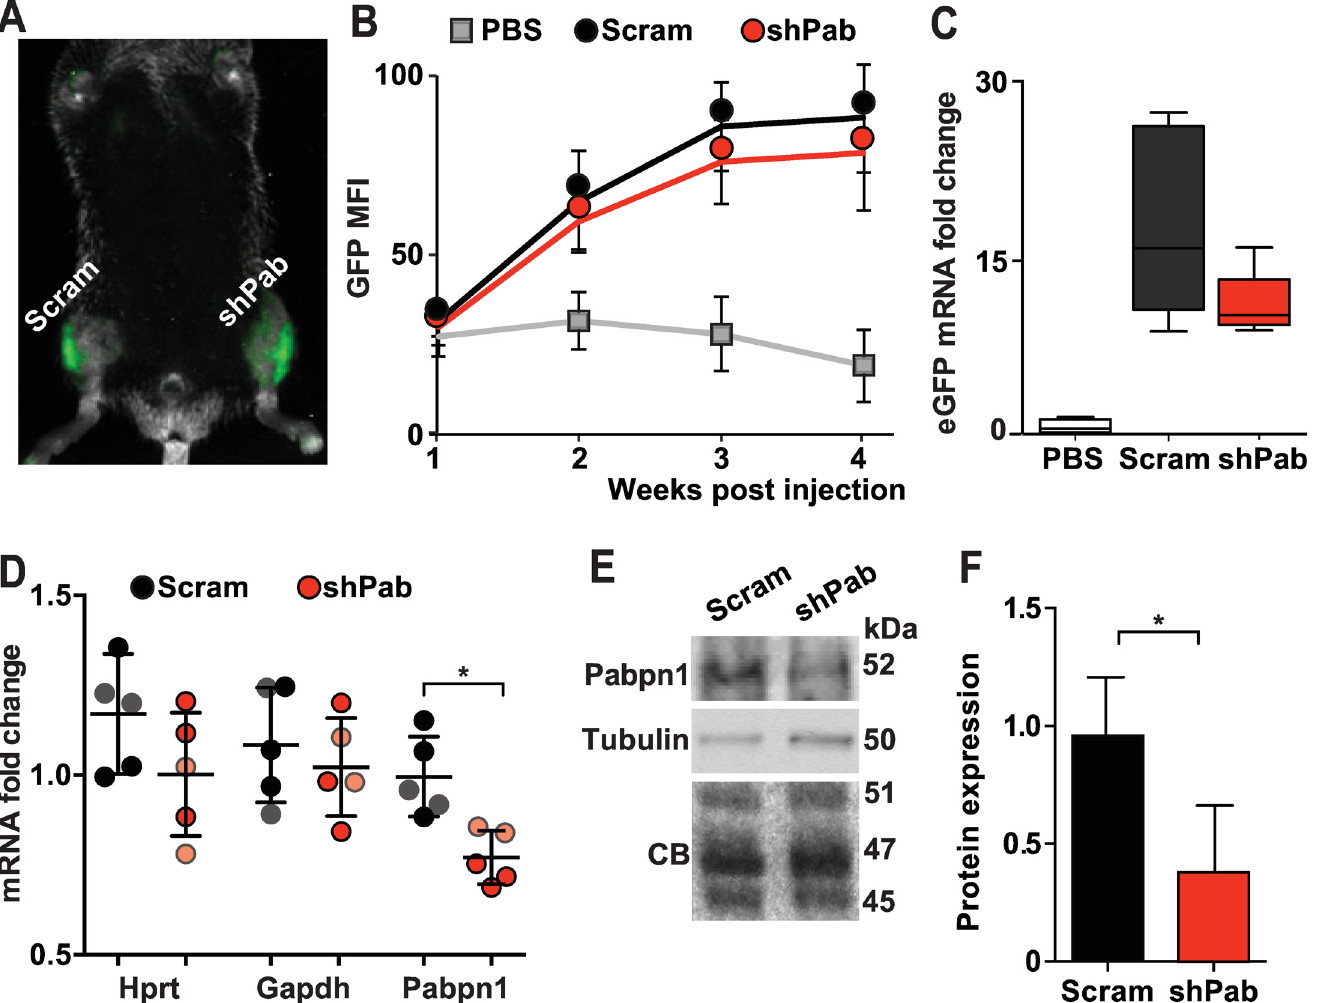
Fig 1. Pabpn1-DR in mouse TA muscles. A. A representative fluorescence image at four weeks post-injection of AAV containing shRNA construct to Pabpn1 or Scramble RNA. The GFP signal is localized into the injected TA muscles. B. GFP expression is stabilized three weeks post injection. C. Box plots show fold-change of eGFP mRNA expression in five mice and averages were normalized to PBS injected mice. D-F. Pabpn1 levels. D. Dot plot shows Pabpn1 mRNA Hprt and Gapdh levels in all injected mice. Hprt and Gapdh levels were normalized to mean Ct value in PBS injected mice. Pabpn1 levels were normalization to the mean of Gapdh and Hprt and PBS injected. Faded color circles mark mice with lower Pabpn1 levels. Means and SD are depicted with lines. E. A representative Western blot shows Pabpn1 and Tubulin proteins. Loading controls are denoted by Tubulin or Coomassie blue (CB) stained gel. F. Bar chart shows mean Pabpn1 accumulation is Scram and shPab muscles. Pabpn1 levels were normalized to the average of three proteins (45, 47 and 51 kDa) from the CB gel. Averages and SD are from three mice with lowest Pabpn1 levels. Statistical significance was assessed by paired Student ’ s t- tests. P-values < 0.05 was considered statistically significant and indicated by an